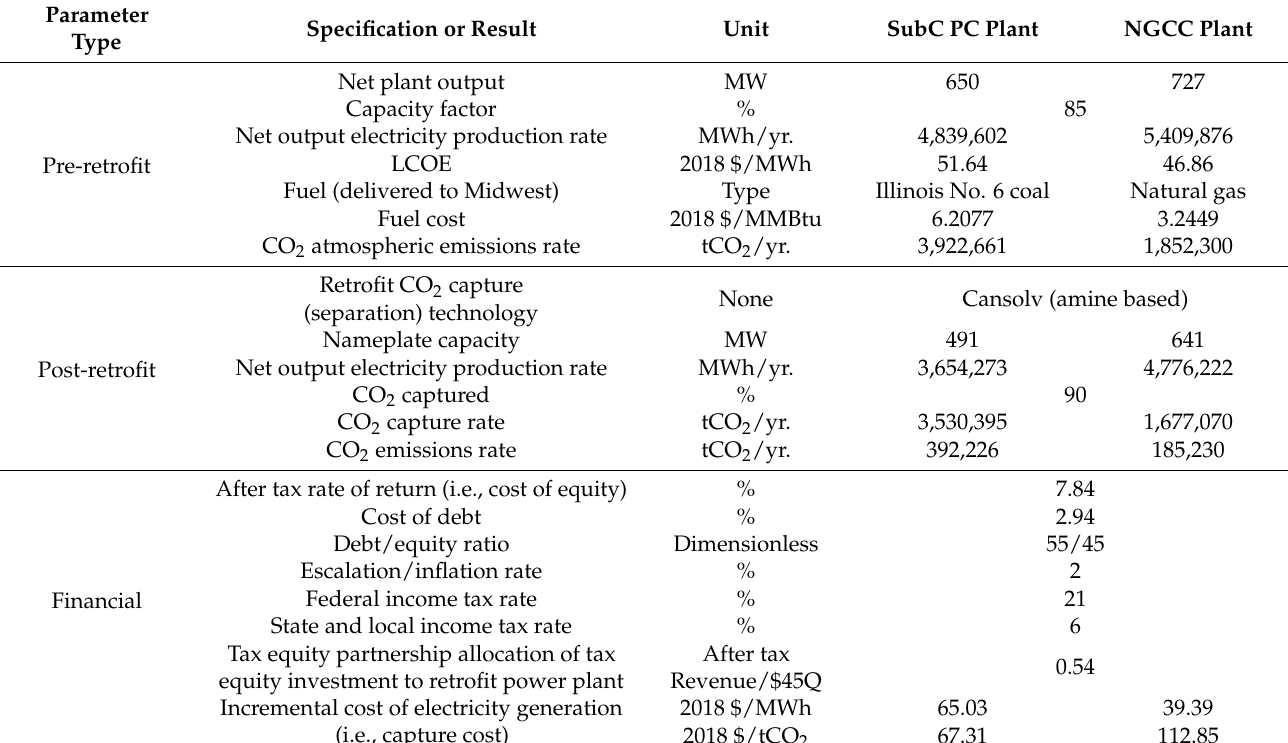
Table A1. Key specifications and results from the Baseline Study and BB4R used in the